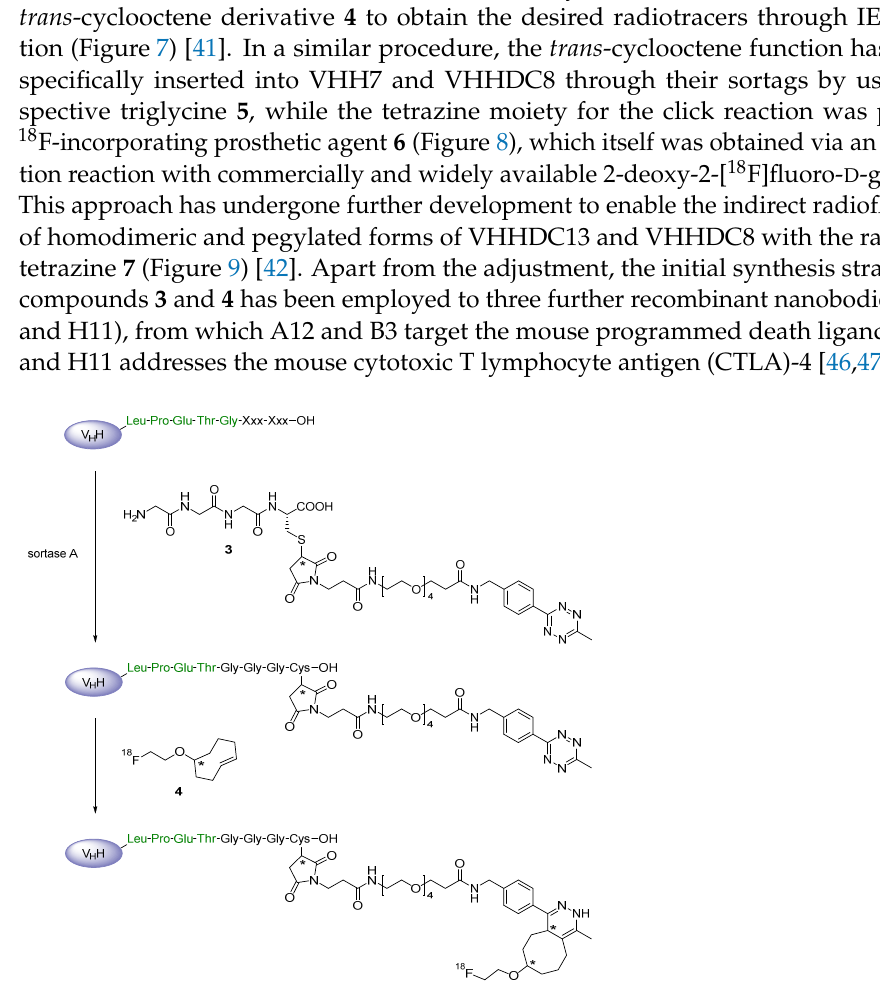
Figure 7. Site-specific insertion of 3 at the nanobody’s C -terminus via sortase A and subsequent inverse-electron demand Diels-Alder (IEDDA) cycloaddition with 4 .